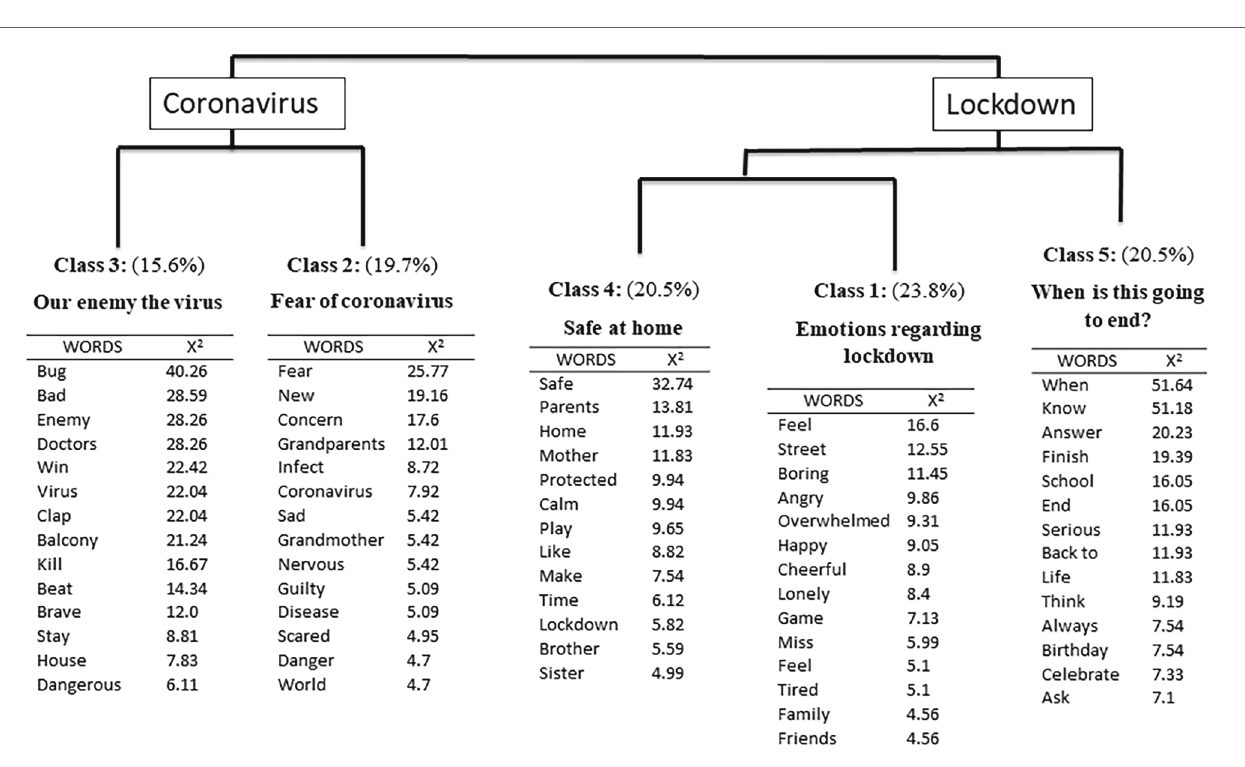
FIGURE 1 | The hierarchical clustering dendrogram of the free association exercise, showing the most frequent words and the words with the greatest association χ 2 (1), p <